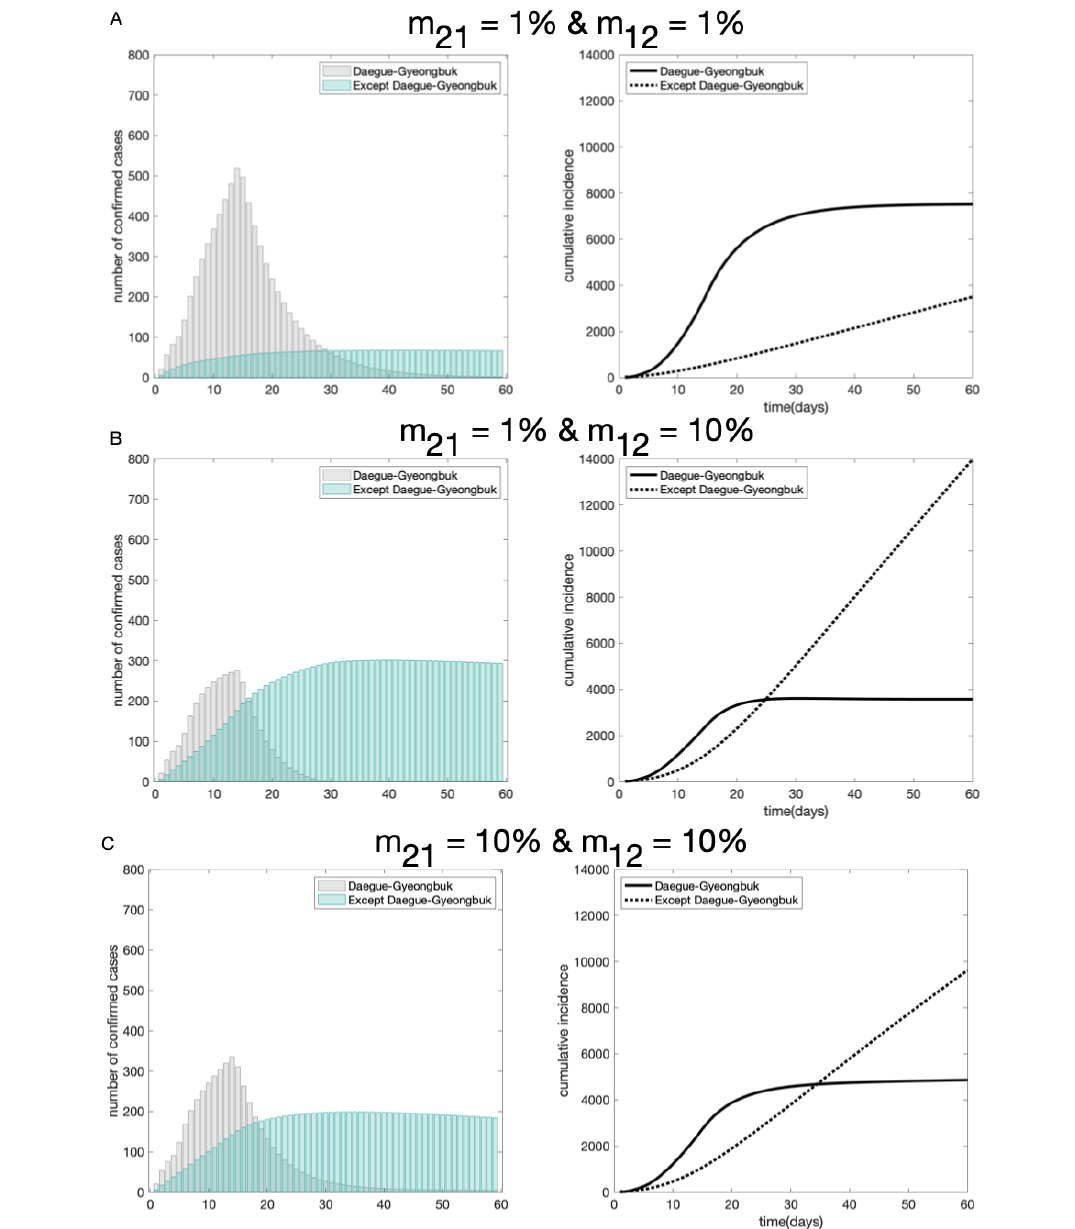
Figure 8. The impact of different motility on daily incidences and cumulative incidence. ( A ) 1% of population is traveling between two patches. ( B ) 1% of population in patch 2 migrates to the patch 1, while 10% of population in patch 1 migrates to the patch 2. ( C ) 10% of population in both patches are traveling between two